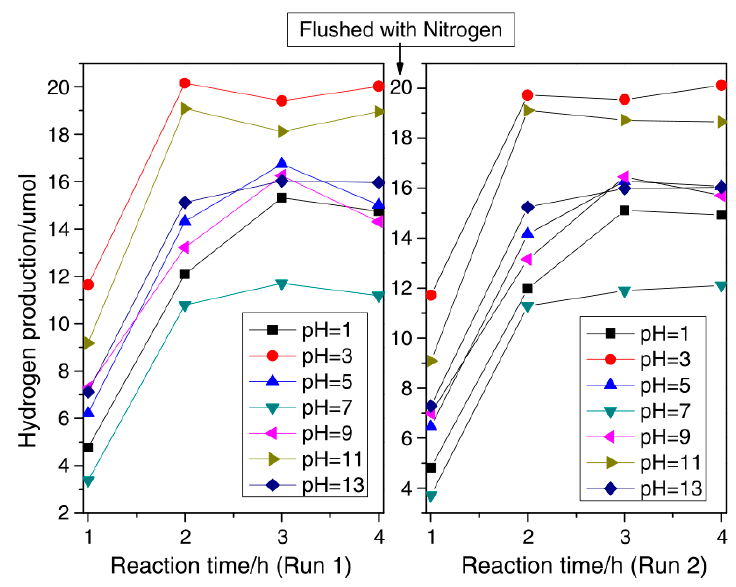
Figure 9. The time courses of photocatalytic hydrogen production over BYV (x = 0.5) under visible light at different pH. (Adapted from Ref. [96]).